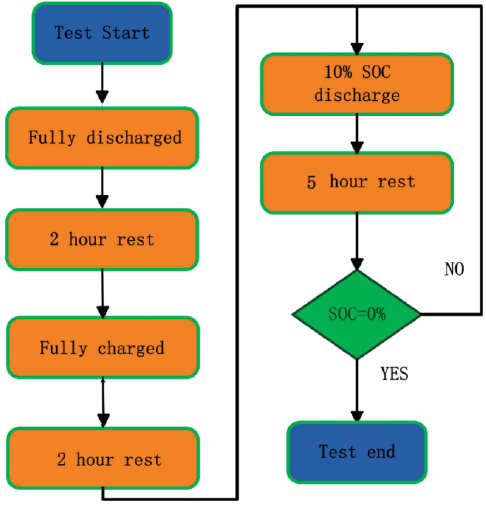
Figure 2. Flow chart of an open ‐ circuit voltage (OCV) test for determining the relationship of OCV and state of charge (SOC).